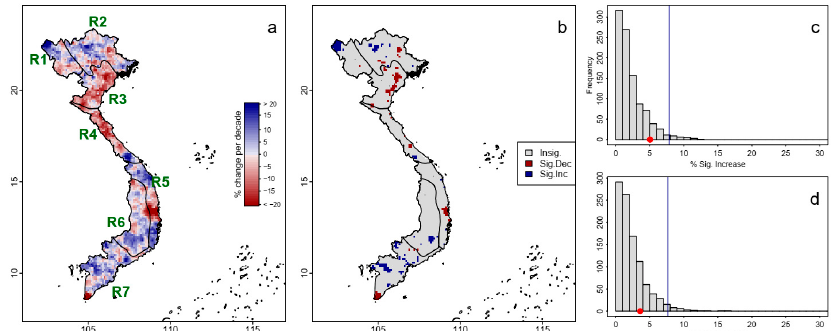
Figure 5. Changes in annual maxima precipitation across Vietnam from 1980 to 2010. ( a ) Normalized Thiel-Sen slope (expressed in % change per decade) of annual maxima precipitation across seven climate regions (polygons bounded by black lines). ( b ) The significance of trends: blue (red) cells indicate locations associated with statistically significant increasing (decreasing) trends at the 5% level. ( c ) The null-hypothesis distribution (grey histogram) and the observed value (red dot) of the percentage of grid cells showing significant increasing trends. ( d ) Similar to ( c ), but for significant decreasing trends. The blue lines in ( c ) and ( d ) represent the 97.5th percentile of the null-hypothesis distribution.